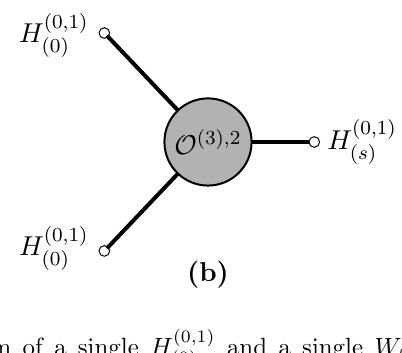
and a single W (0) (0)